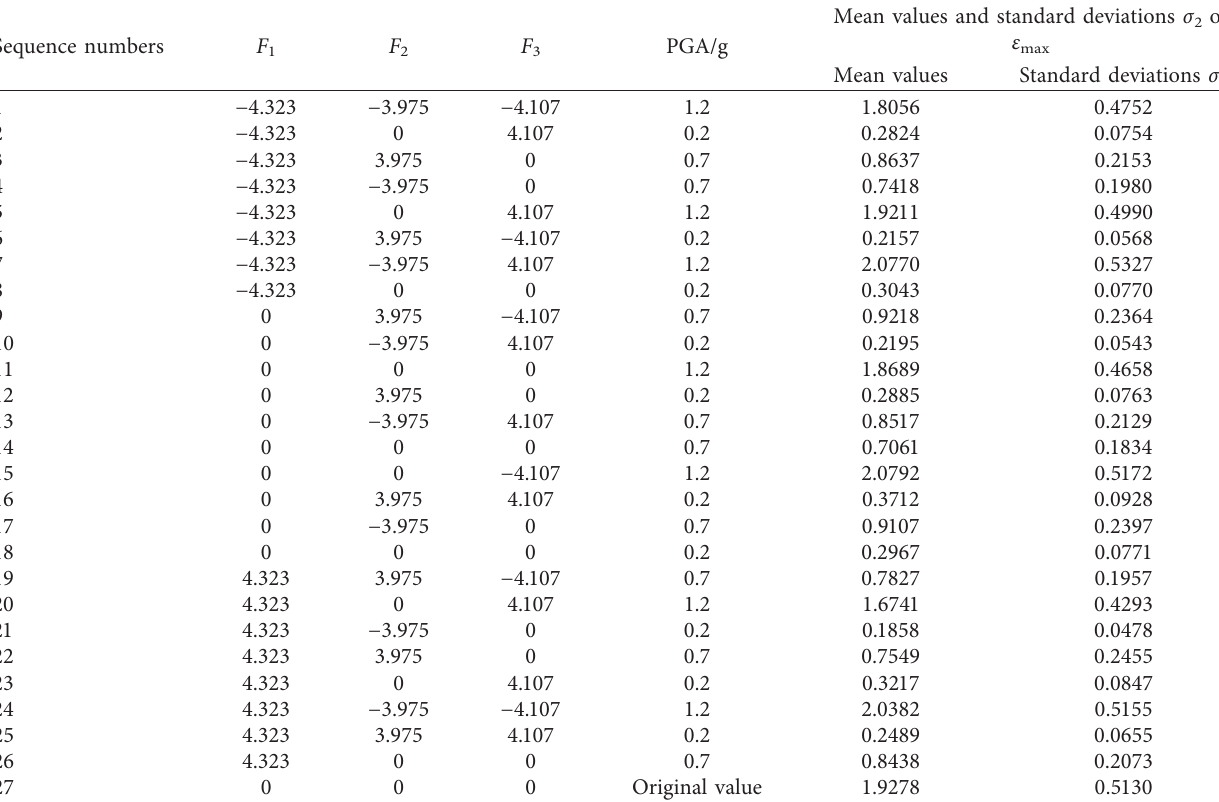
Table 5: Dynamic response analysis results of the